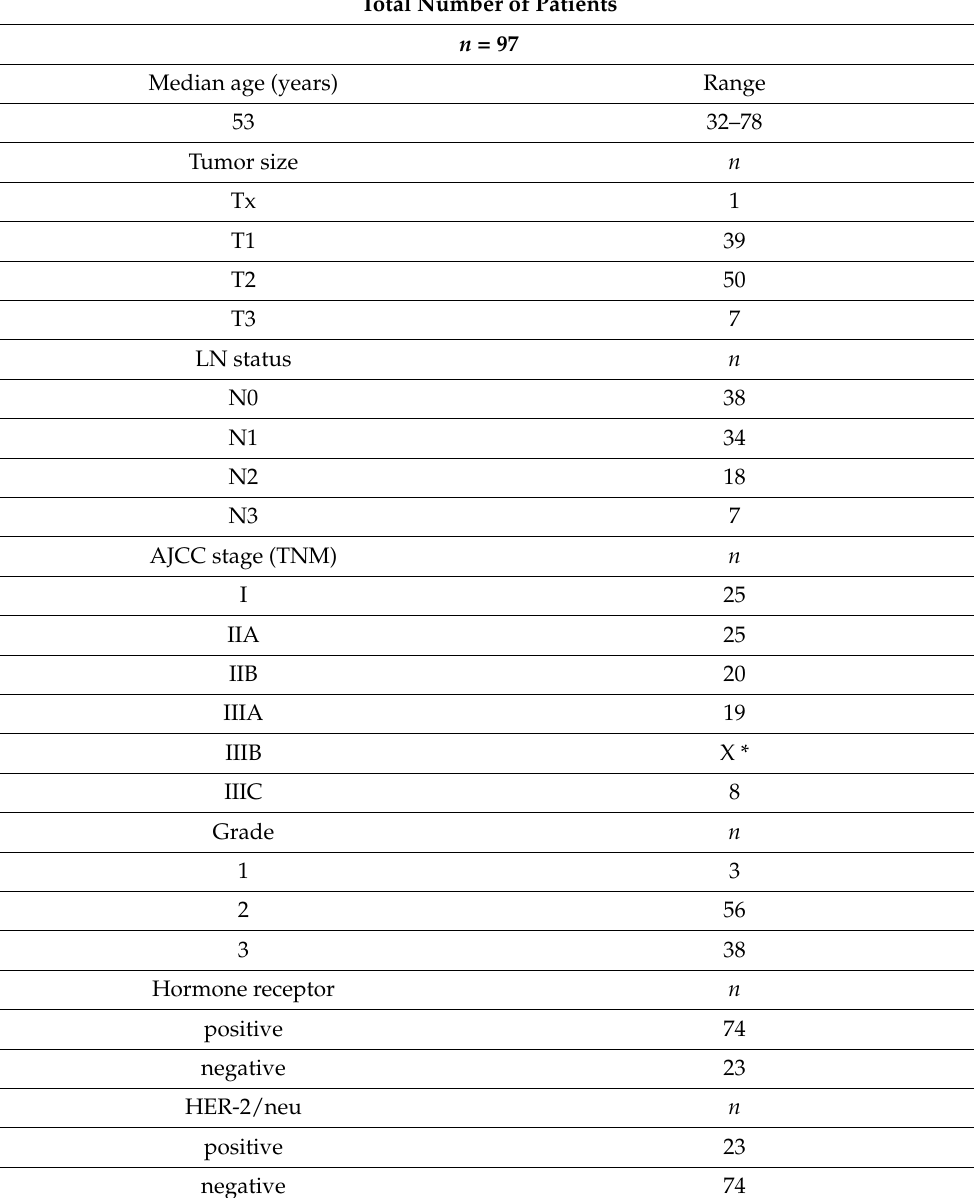
Table 1. Clinicopathological characteristics of